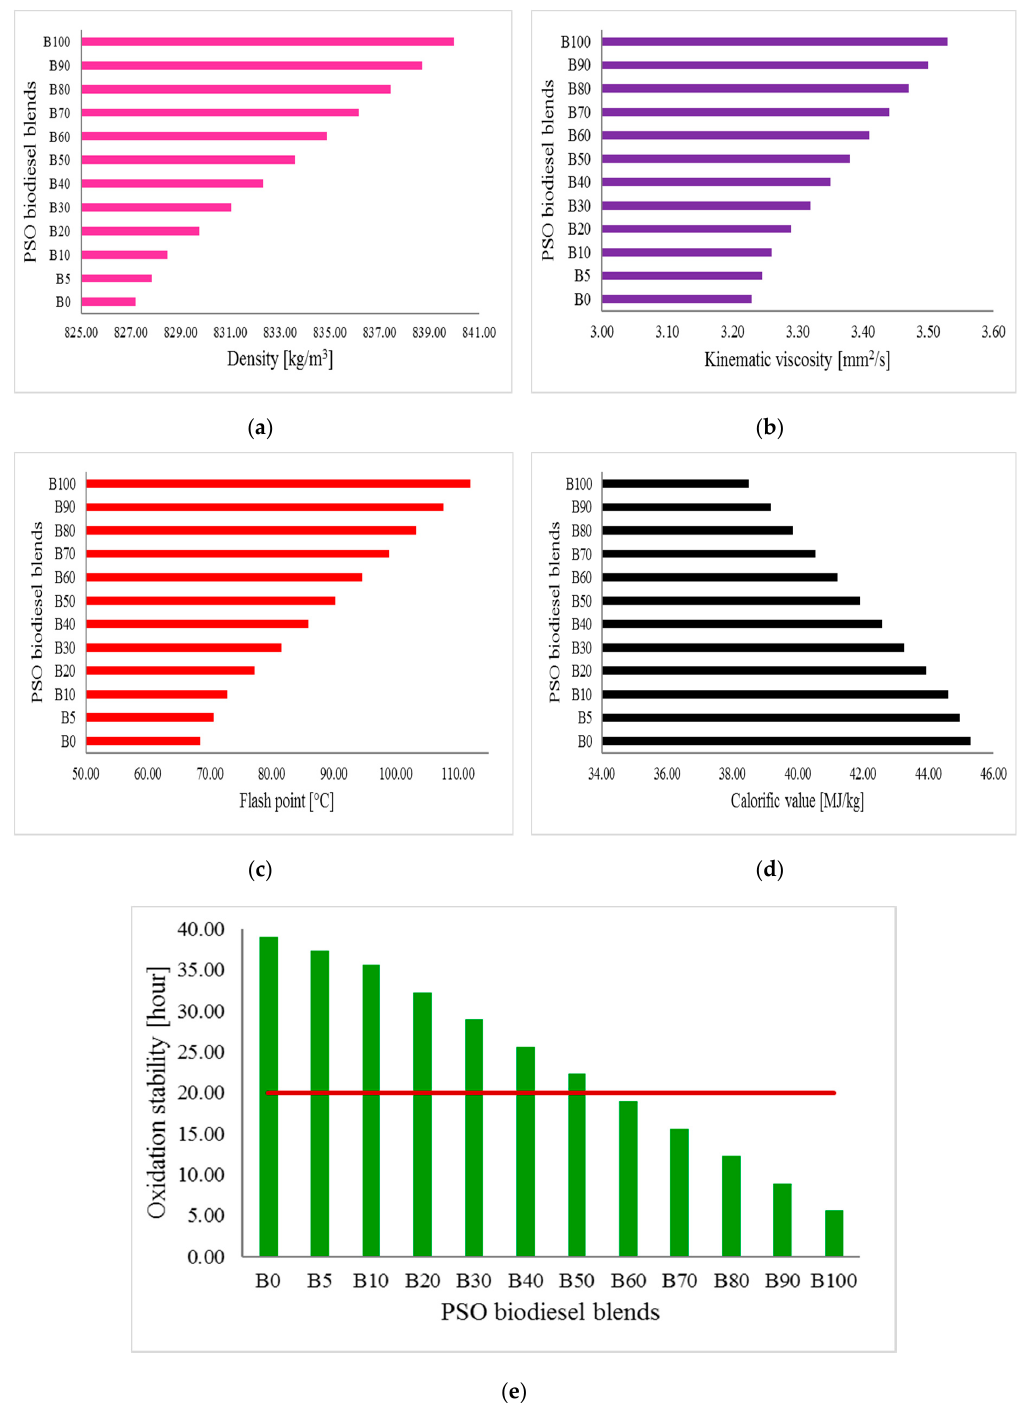
Figure 4. PSO biodiesel-diesel blending effects on: ( a ) density, ( b ) kinematic viscosity, ( c ) flash point, ( d ) calorific value, and ( e ) oxidation stability.